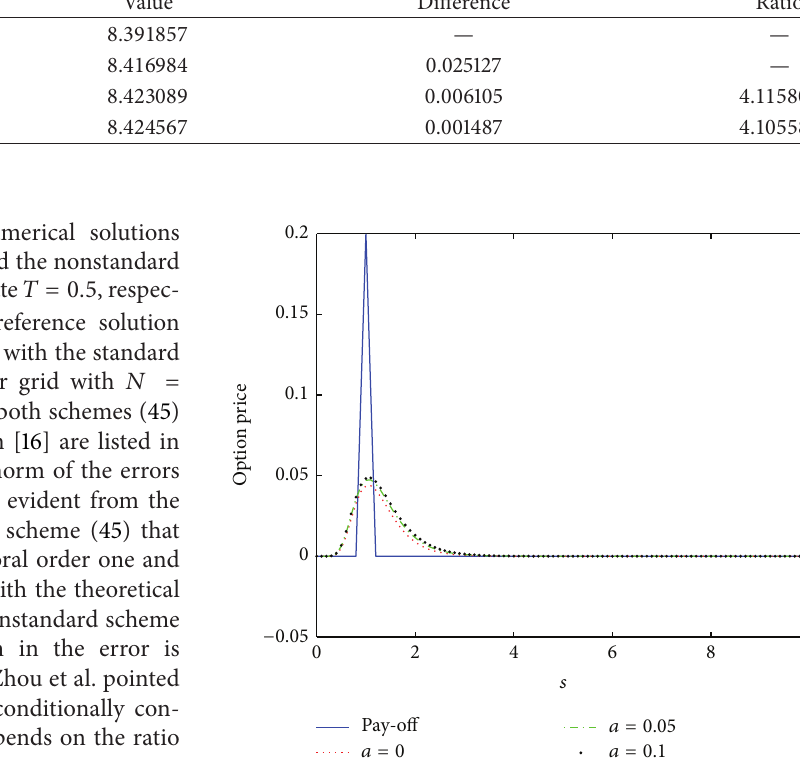
Table 1: Convergence results for the scheme (45) for the transaction costs model together with a vanilla call option, where 𝑎 = 0.015 . 𝑀